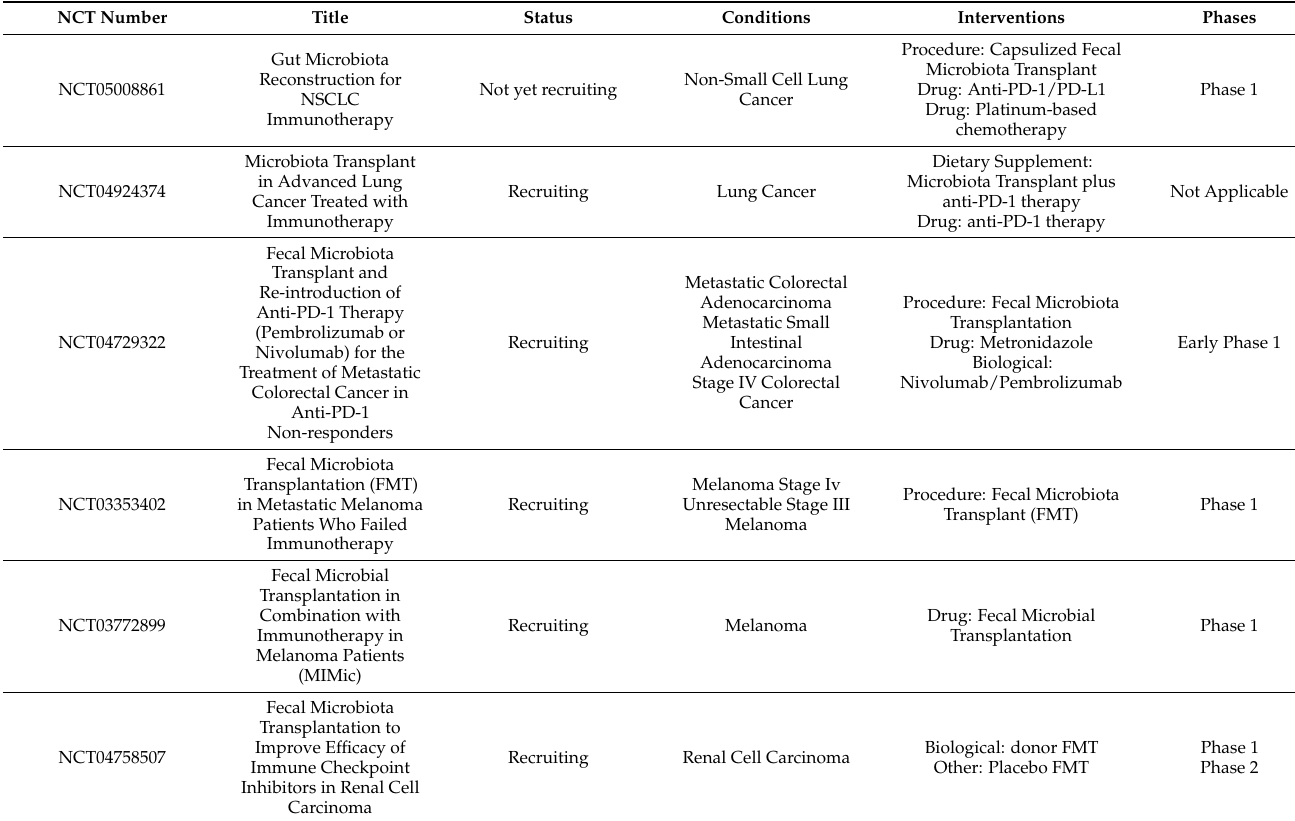
Table 4. Related clinical trials of FMT in cancer